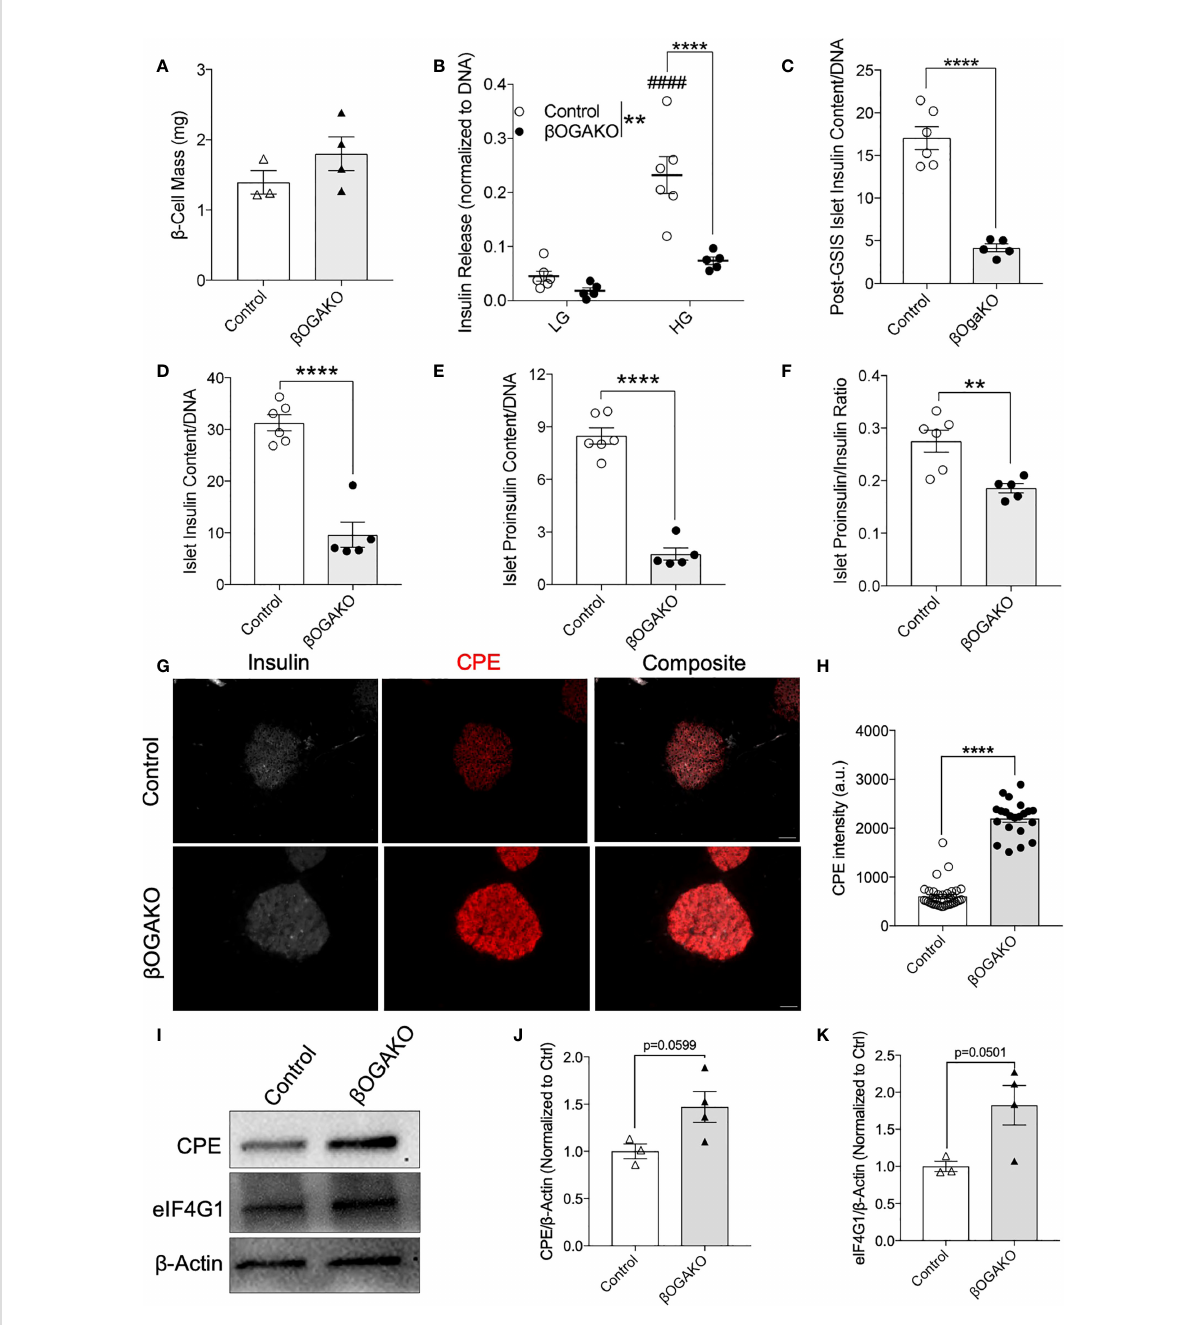
FIGURE 3 Impaired insulin secretion and processing in b -cell OGA de fi cient islets. b -cell mass of Control and b OGAKO female mice at 30-wks of age ( A , n=3-4). In Vitro glucose stimulated insulin secretion assay with isolated primary islets from control and b OGAKO mice at 30-wks of age (B) with post-assay insulin content normalized to DNA (C) (n=5-6). Primary islet insulin (D) and proinsulin € ) content normalized to DNA with proinsulin to insulin content ratio (F) (5-6). Immuno fl uorescence image of pancreatic islets showing CPE (red) and insulin (white) from Control and b OGAKO pancreas (G) and intensity quanti fi cation of CPE in insulin positive cells (H) . Islet analysis from n=2-3 animals. 40x magni fi cation. Scale bar = 50 m m. Representative western blot (I) and quanti fi cation of CPE (J) and eIF4G1 (K) , normalized to beta-Actin (n=3-4). Statistical